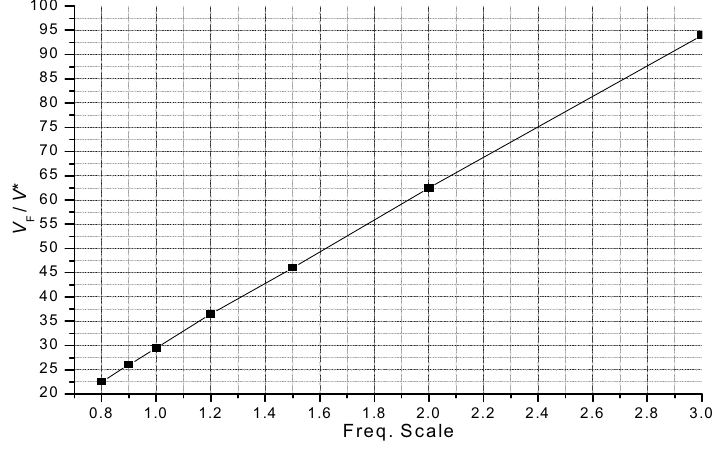
Freq. Scale Fig. 4. The flutter speed versus scale of the chordwise